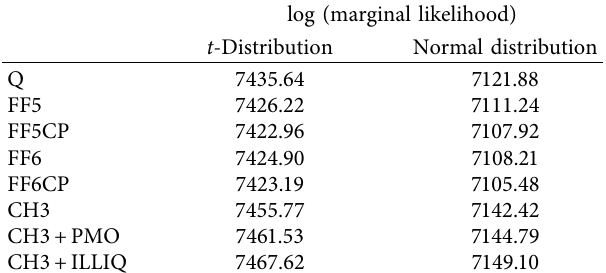
Table 9: Bayesian marginal